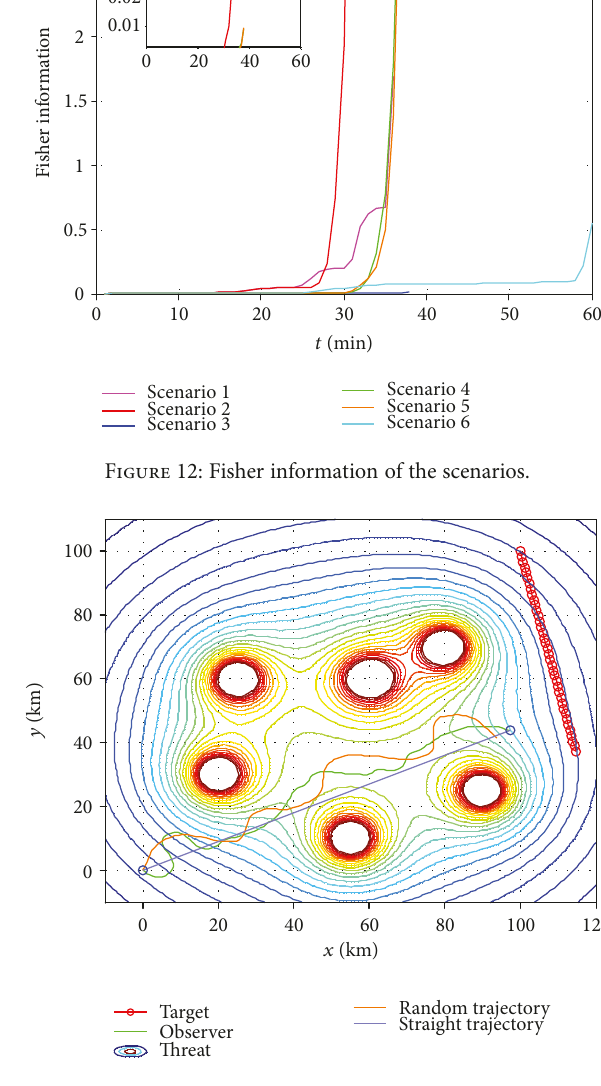
Figure 13: Di ff erent trajectories in scenario 4.